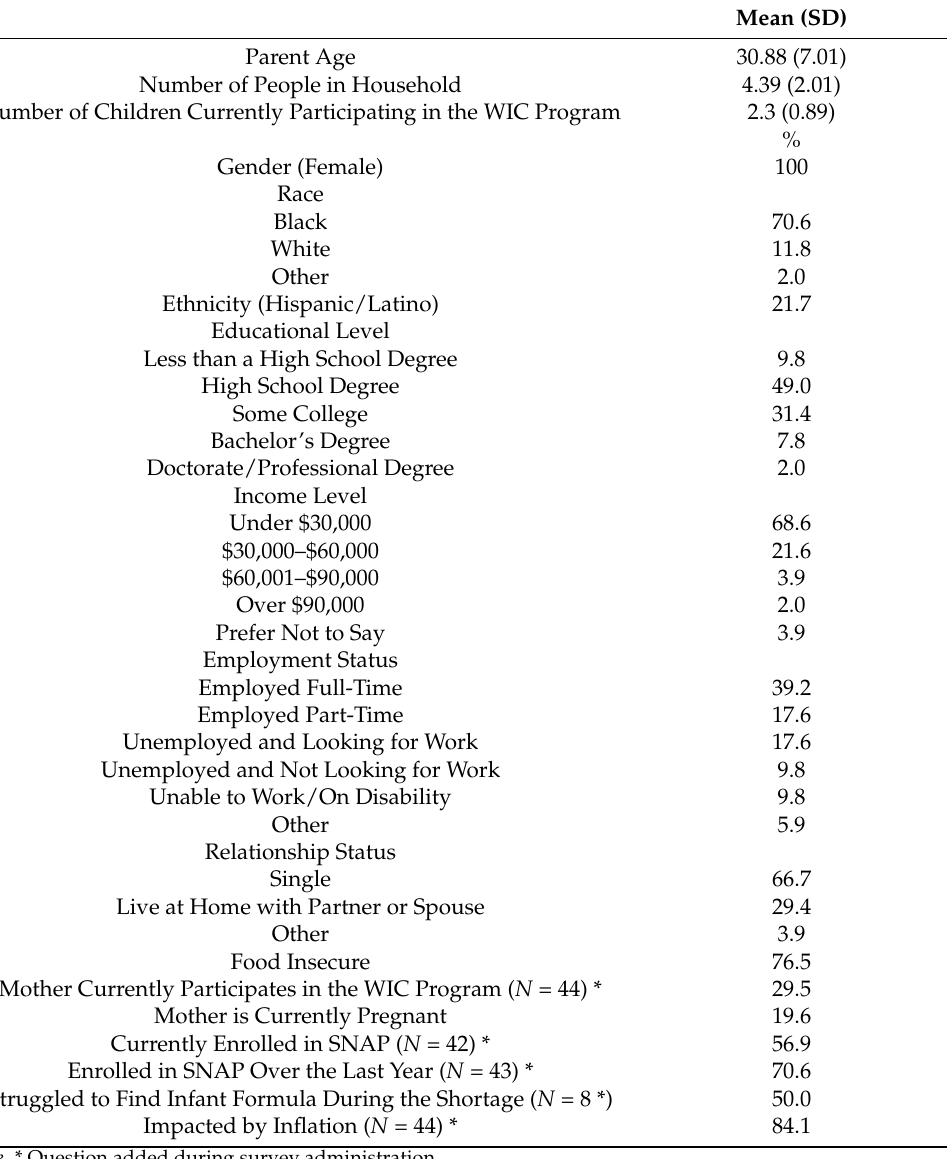
Table 2. Sample characteristics ( N =